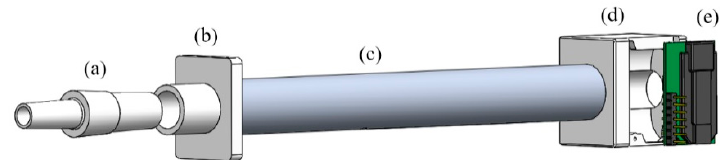
Figure 1. 3D model of sampling tube components: ( a ) One-way mouthpiece; ( b ) Front-end tube connector; ( c ) Sampling tube; ( d ) Back-end tube connector; ( e ) Sensor